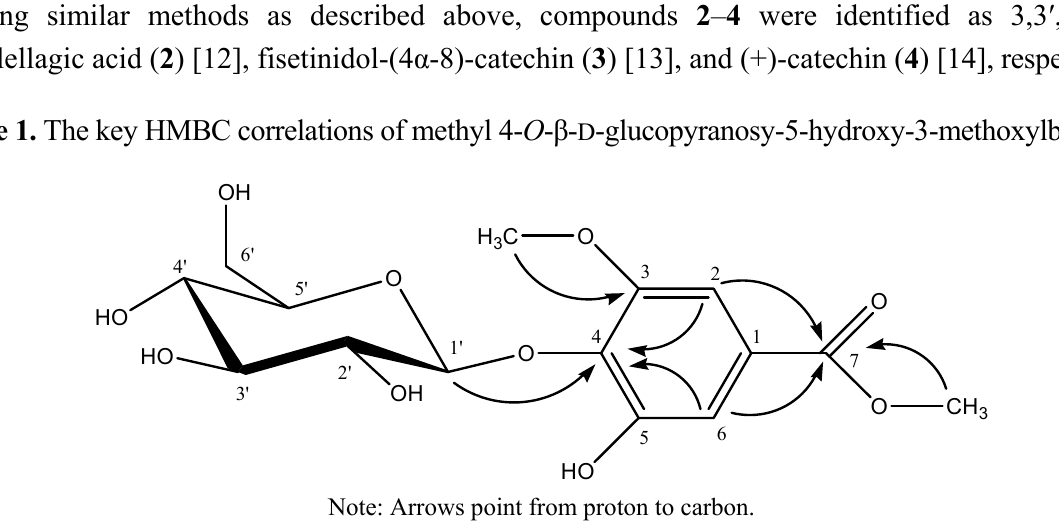
Note: Arrows point from proton to carbon.